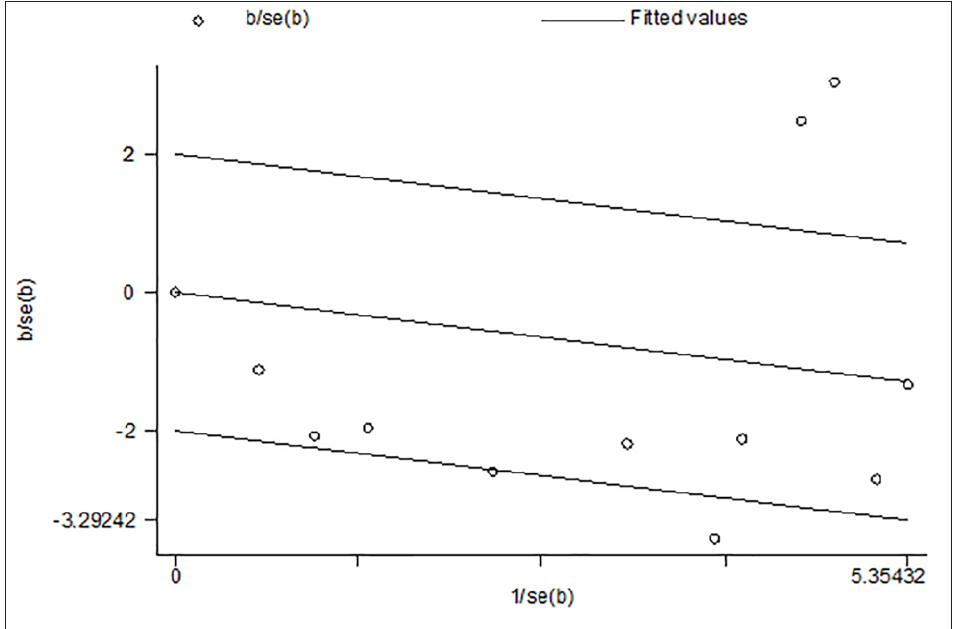
Fig. 6. Galbraith Radial plot mentioned in the